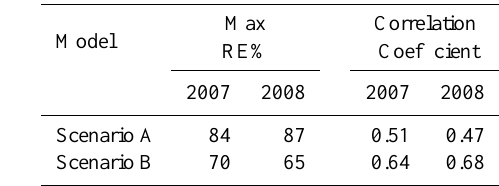
Table 1. Maximum RE% and correlation coefficient associated with the output of MLP-NN model on a weekly/monthly basis for years 2007 and